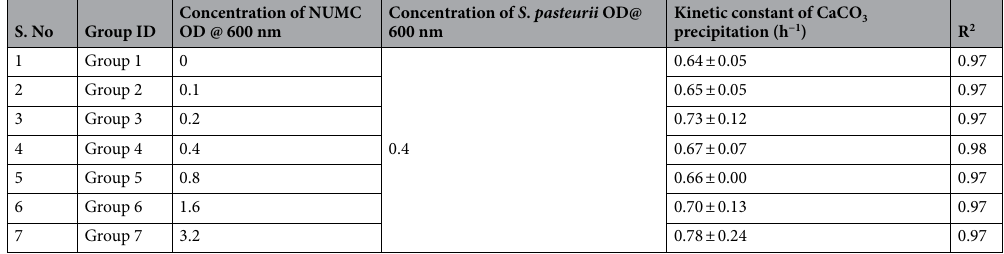
Table 2. The kinetic constants of calcium carbonate precipitation. ± indicates the standard deviation of two independent trials. NUMC Native Ureolytic Microbial Community, S . pasteurii Sporosarcina